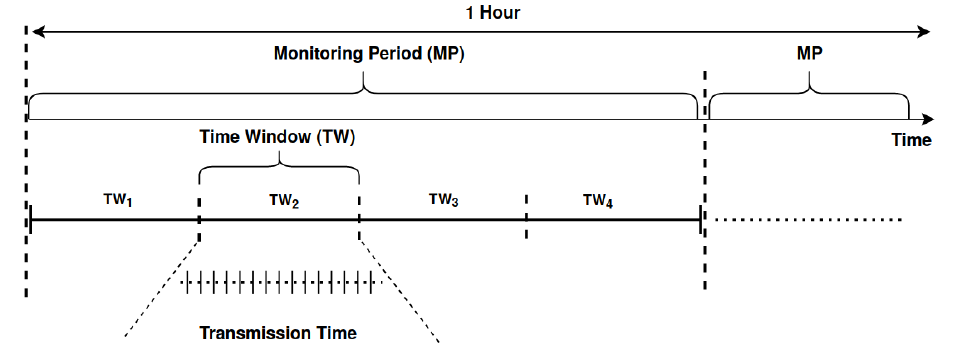
Figure 4. Monitoring period